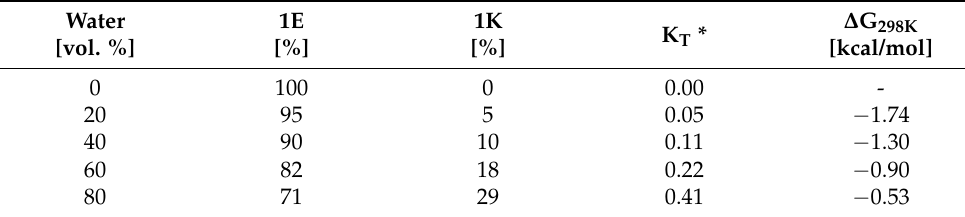
Table 2. Parameters of the 1E (cid:10) 1K tautomeric equilibrium as a function of the water content in acetonitrile/water binary mixture at 298 K.